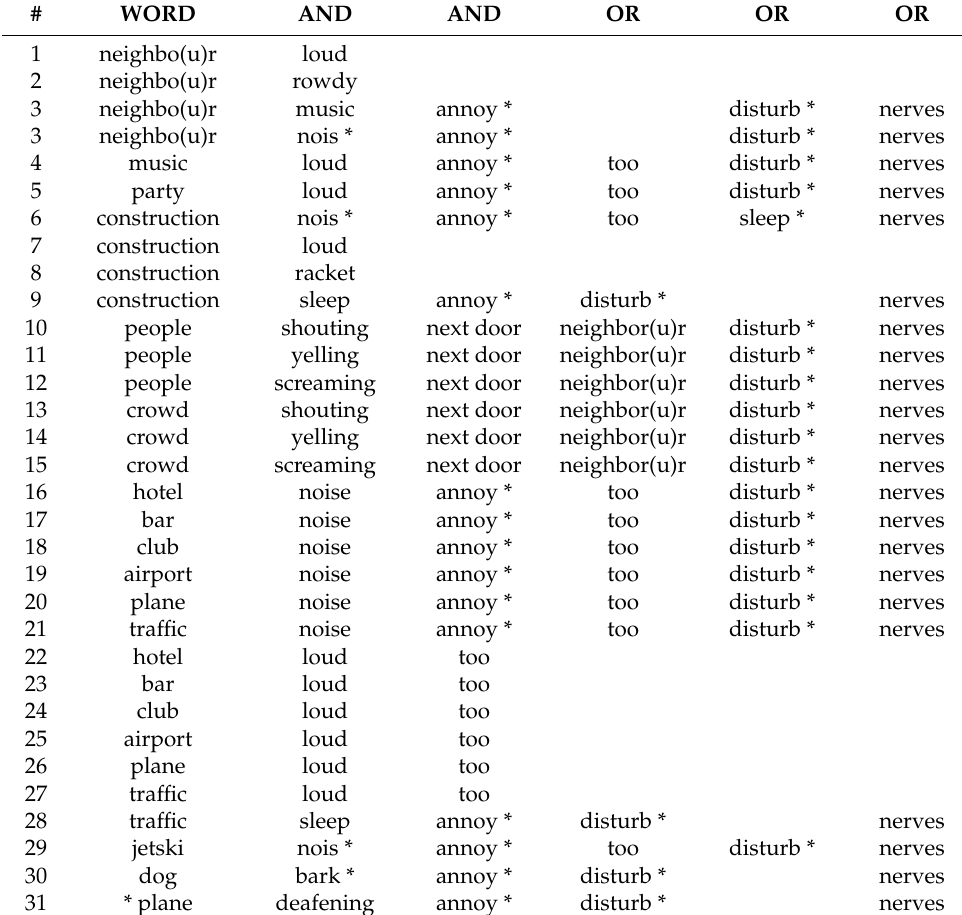
Table 2. Lexicon used for filtering Tweets, UAE 2015 (*-represents